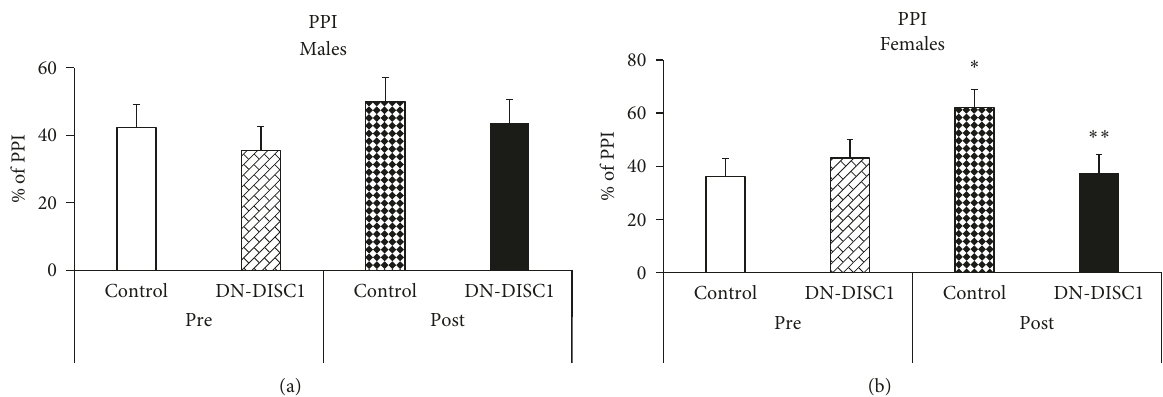
Figure 3: Effects of GxE on PPI. PPI of the acoustic startle was assayed in control and DN-DISC1 male (a) and female (b) mice; n group for male mice; n 5 per group for female mice. Two-way ANOVA of PPI data for male mice showed no effects. Two-way ANOVA for (cid:31) female mice showed a significant genotype by infection interaction, F (1,19)